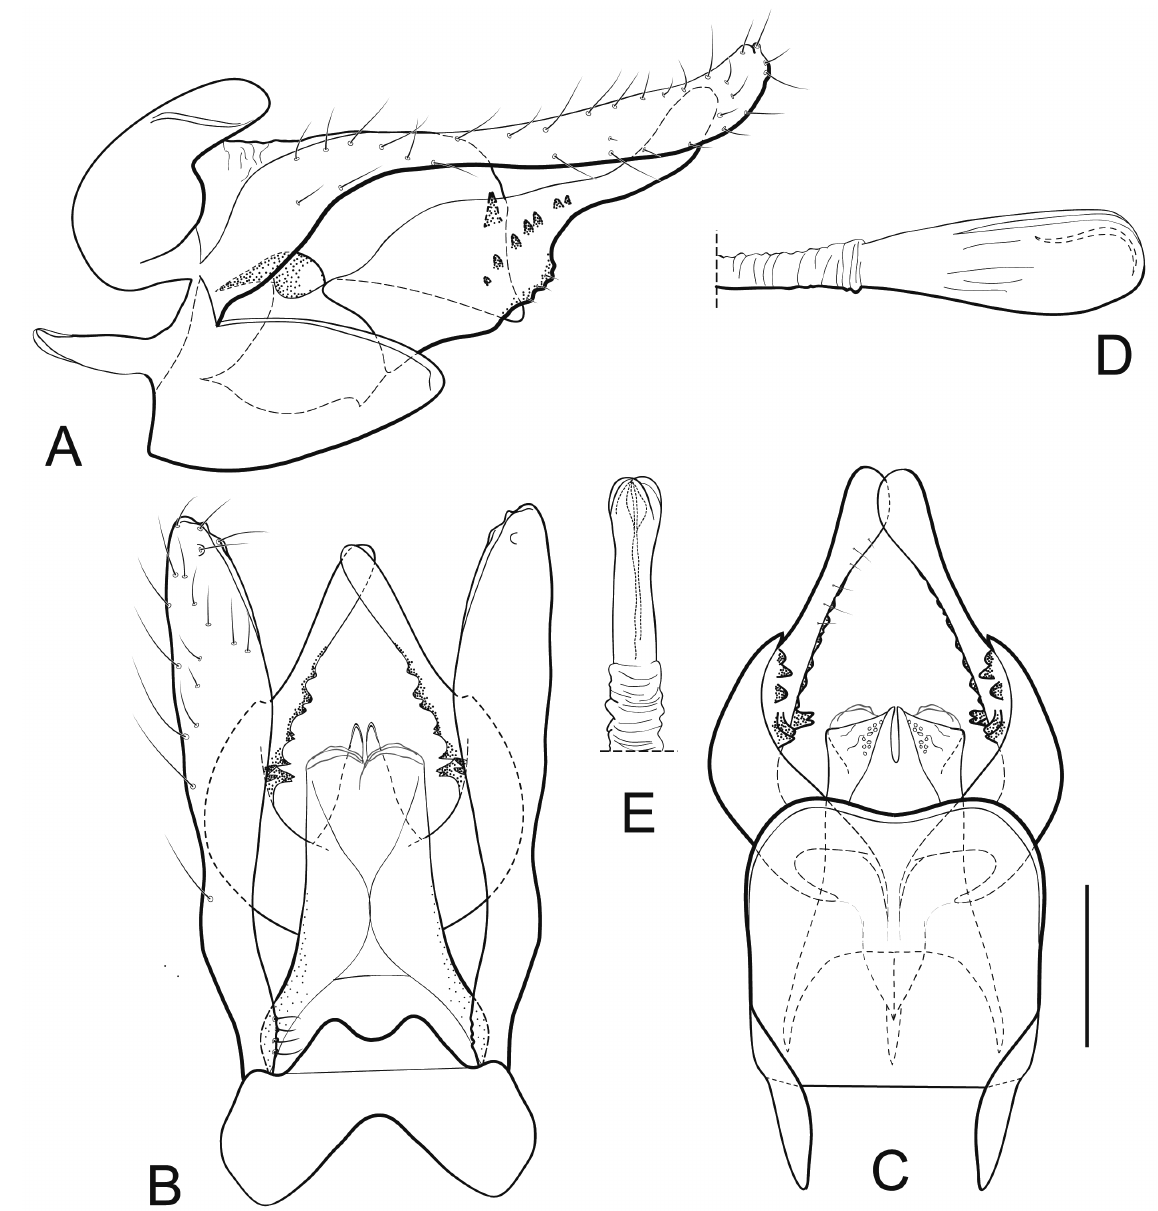
Fig. 7. Xiphocentron ( Antillotrichia ) redentor sp. nov., holotype, adult, ♂, genitalia. A . Left lateral view. B . Dorsal view. C . Ventral view. D . Phallus apex, left lateral view. E . Phallus, apex in dorsal view. Scale bar = 0.1